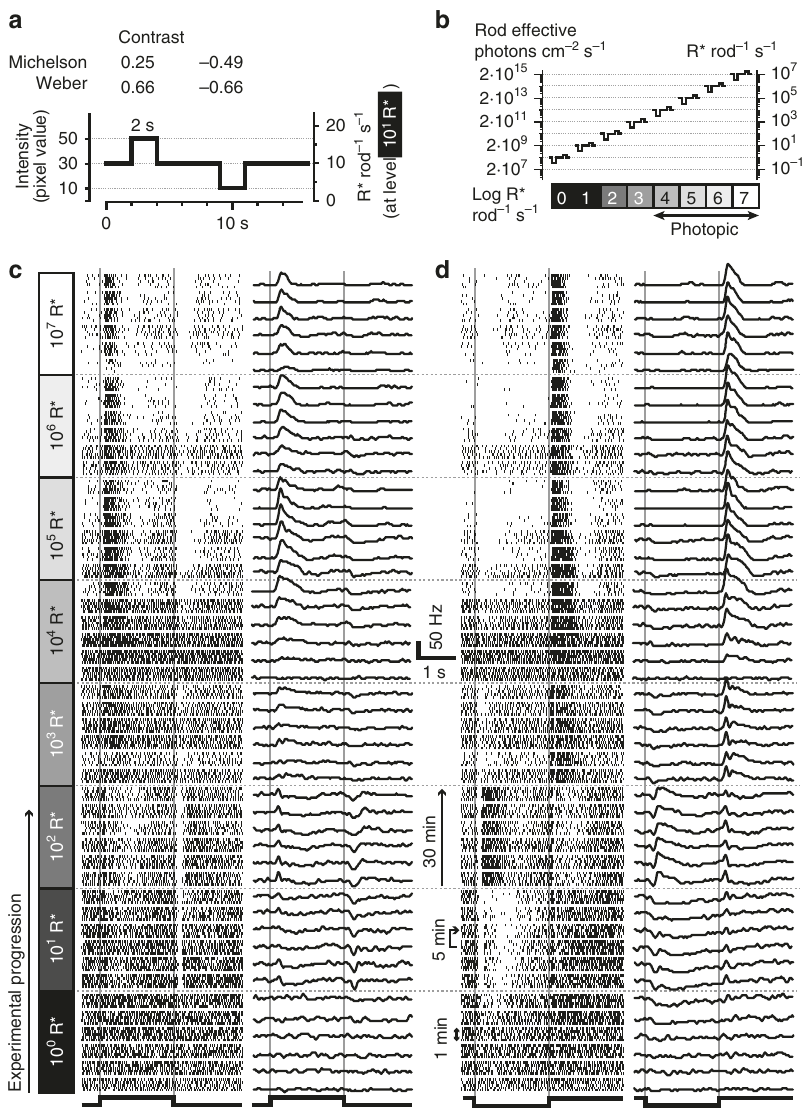
Fig. 2 Example responses of a single Cnga3 − / − ganglion cell across brightness levels. a Full- fi eld contrast step stimulus, consisting of positive and negative contrast steps. b Absolute intensities of the stimulus shown in a at different experimental light levels. c , d Raster plots (left) and fi ring rates (right) for a single ganglion cell in response to the full- fi eld positive ( c ) and negative ( d ) contrast steps. Blocks of fi ve consecutive repetitions (left) are averaged in one trace on the right. This cell showed responses at all light levels (very weakly responding at 10 0 R* rod − 1 s − 1 ), with a short suppression of responses in the beginning of 10 4 R* rod − 1 s − 1 . Note that in this ganglion cell, the rod-mediated responses are even stronger at high (10 4 – 10 7 R* rod − 1 s − 1 ) than at lower (1 – 10 3 R* rod − 1 s − 1 ) light